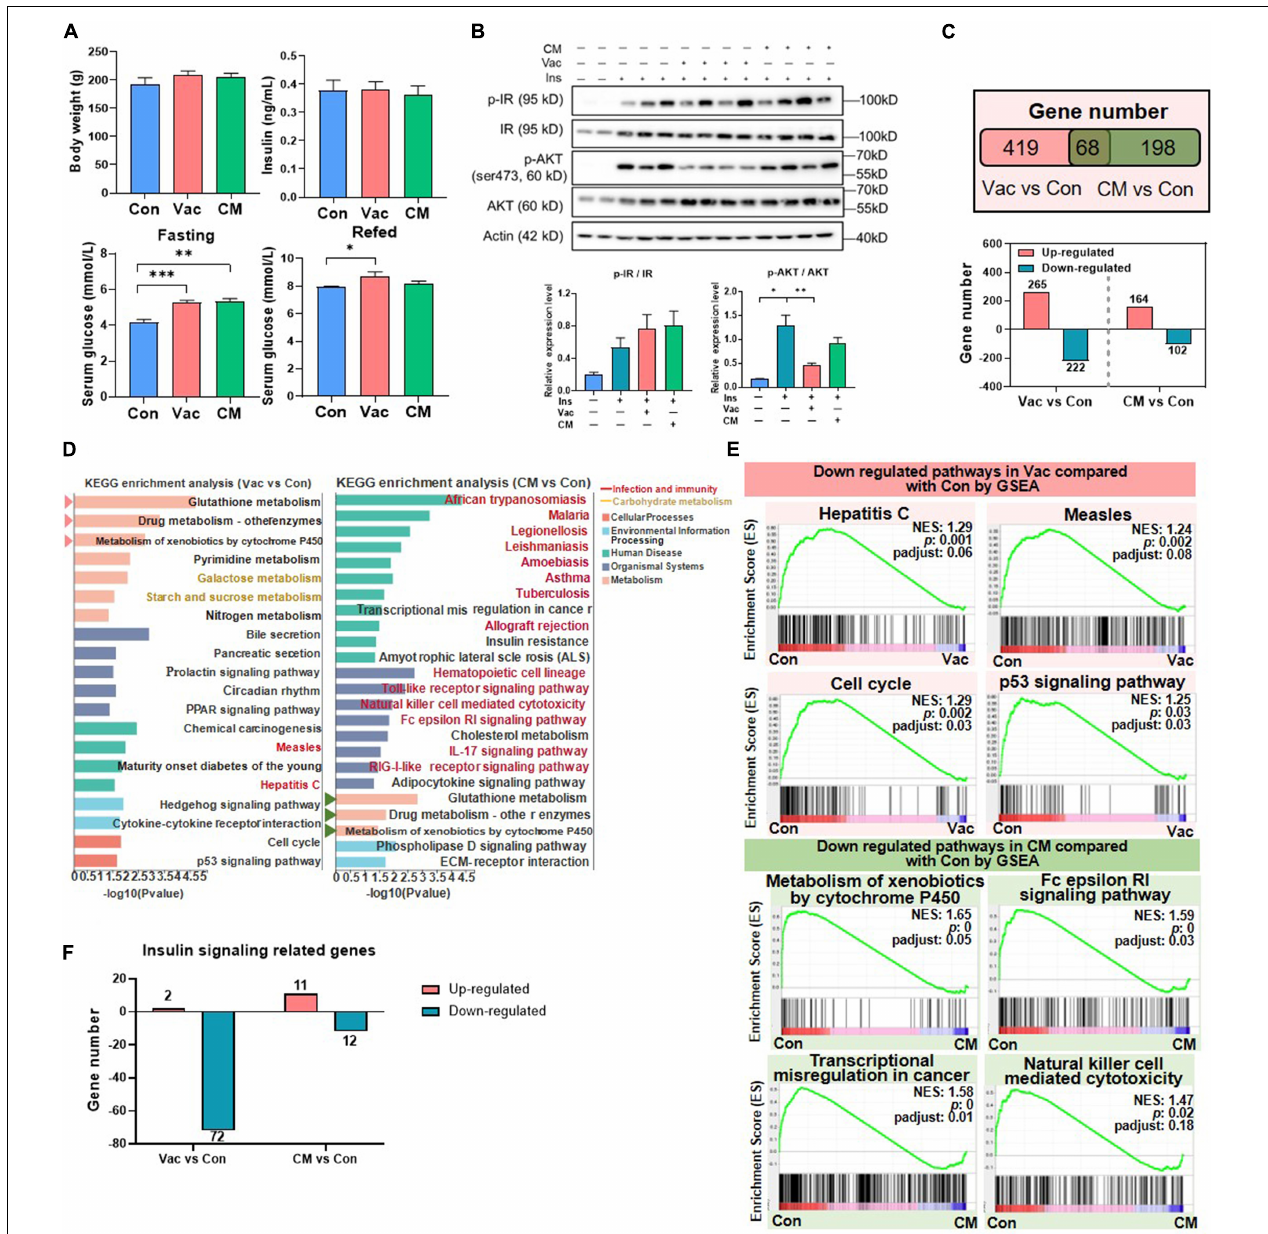
FIGURE 2 | The impact of antibiotic intervention on rat phenotype and liver transcriptome. (A) Body weight, fasting serum insulin, fasting serum glucose, and fed serum glucose after antibiotic intervention. (B) Western blot analysis of hepatic protein level. Rats were injected with insulin 8 min before tissues were collected. For index determination, n = 5–6 per group; for protein analysis, n = 2–4 per group; * p < 0.05, ** p < 0.01, and *** p < 0.001 by Student’s t -test. (C) Venn diagram of the overlap of differential expressed genes between Vac vs. Con and CM vs. Con ( p < 0.05 based on edgeR software, and FC ≤ 0.5 or ≥ 2). (D) KEGG pathway enrichment analysis of 487 and 266 differential genes. Triangles on the left showed the same pathways between Vac vs. Con and CM vs. Con. (E) The same pathways between Gene Set Enrichment analysis (GSEA) and KEGG pathway enrichment analysis. (F) Different regulatory effects of Vac and CM on insulin related genes. n = 4 per group for